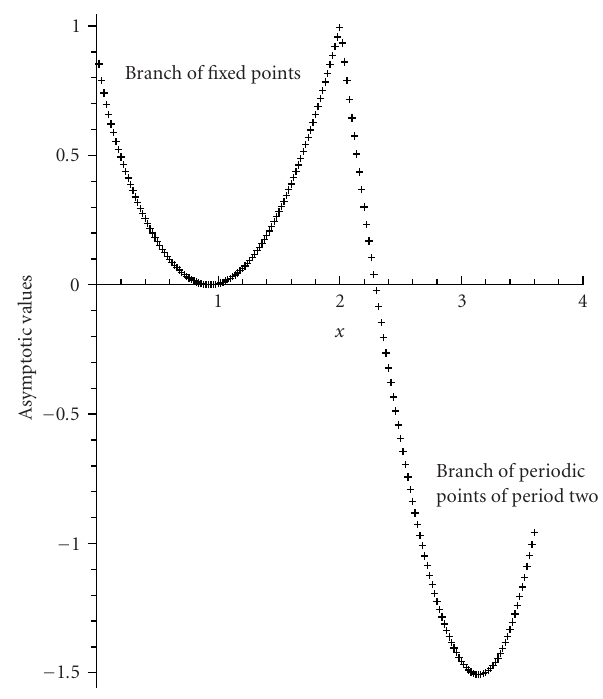
Figure 5.1. Branches of periodic points of periods one and